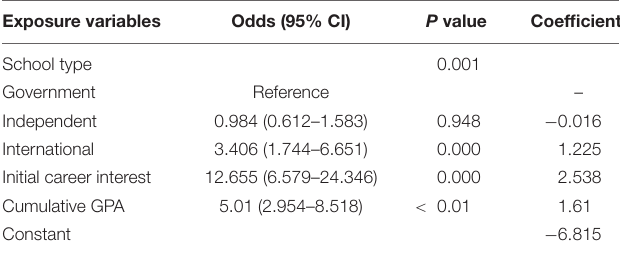
TABLE 5 | Logistic regression and OR for school type and initial career interest.